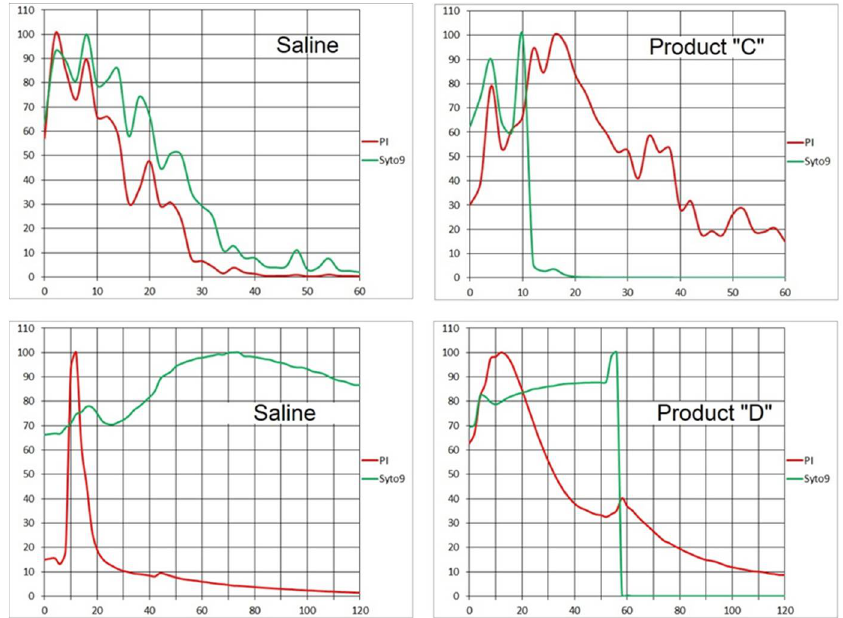
Figure 15. Upper diagrams (Product “C”): Time-lapse record of PI (red) and Syto 9 (green) fluorescence signal from a mixed biofilm of S. epidermidis and bifidobacteria exposed alternatively to 0.89% saline and the product. Time series (2-min intervals) synchronized with pump delivery (2 mL/hour). Horizontal axis: time in minutes. Vertical axis: % of maximum frame luminance. Lower diagrams (Product “D”): Time-lapse record of PI (red) and Syto 9 (green) fluorescence signal from a biofilm of S. epidermidis exposed alternatively to 0.89% saline and the product. Time series (2-s intervals) synchronized with pump delivery (1 mL/min). Horizontal axis: time in seconds. Vertical axis: % of maximum frame luminance.